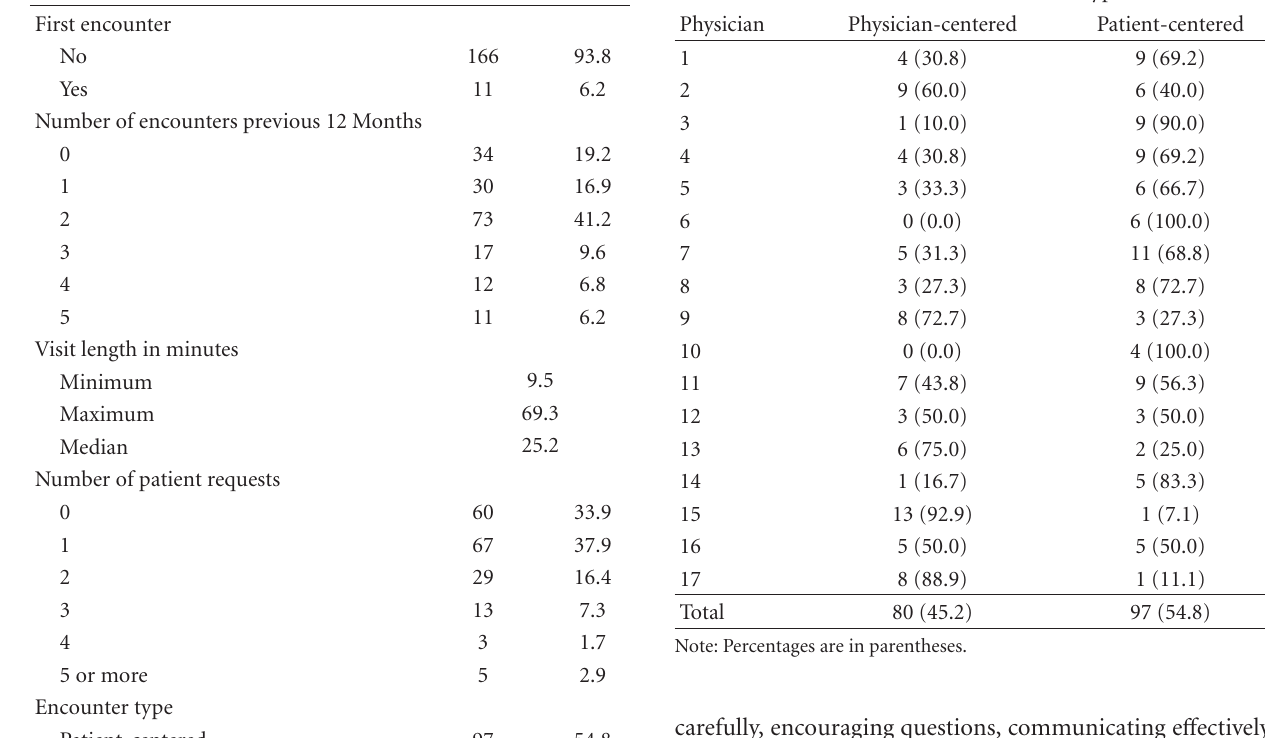
Table 5: Frequency and percent of encounter types by physician. N % Encounter